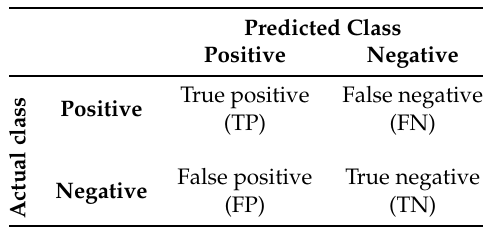
Table 6. Binary confusion